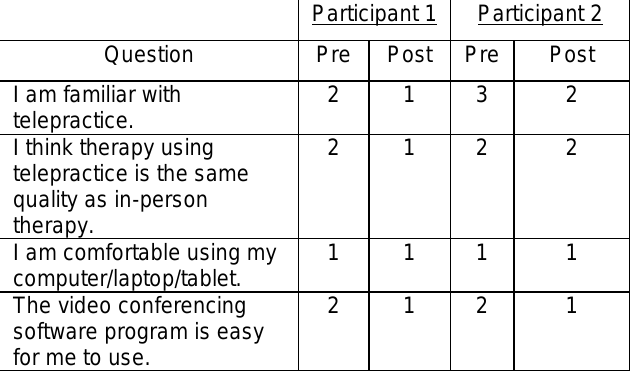
Table 3. Telepractice Questionnaire Scores for People with